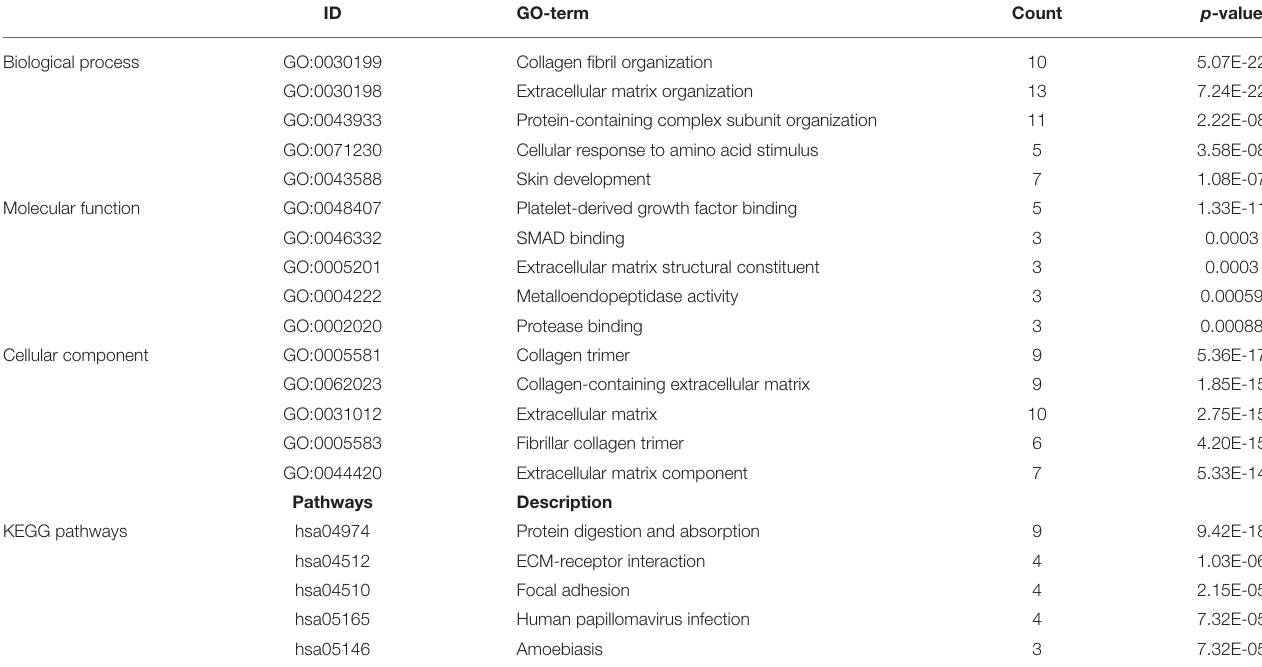
TABLE 1 | Module 1 GO and KEGG pathways analysis.